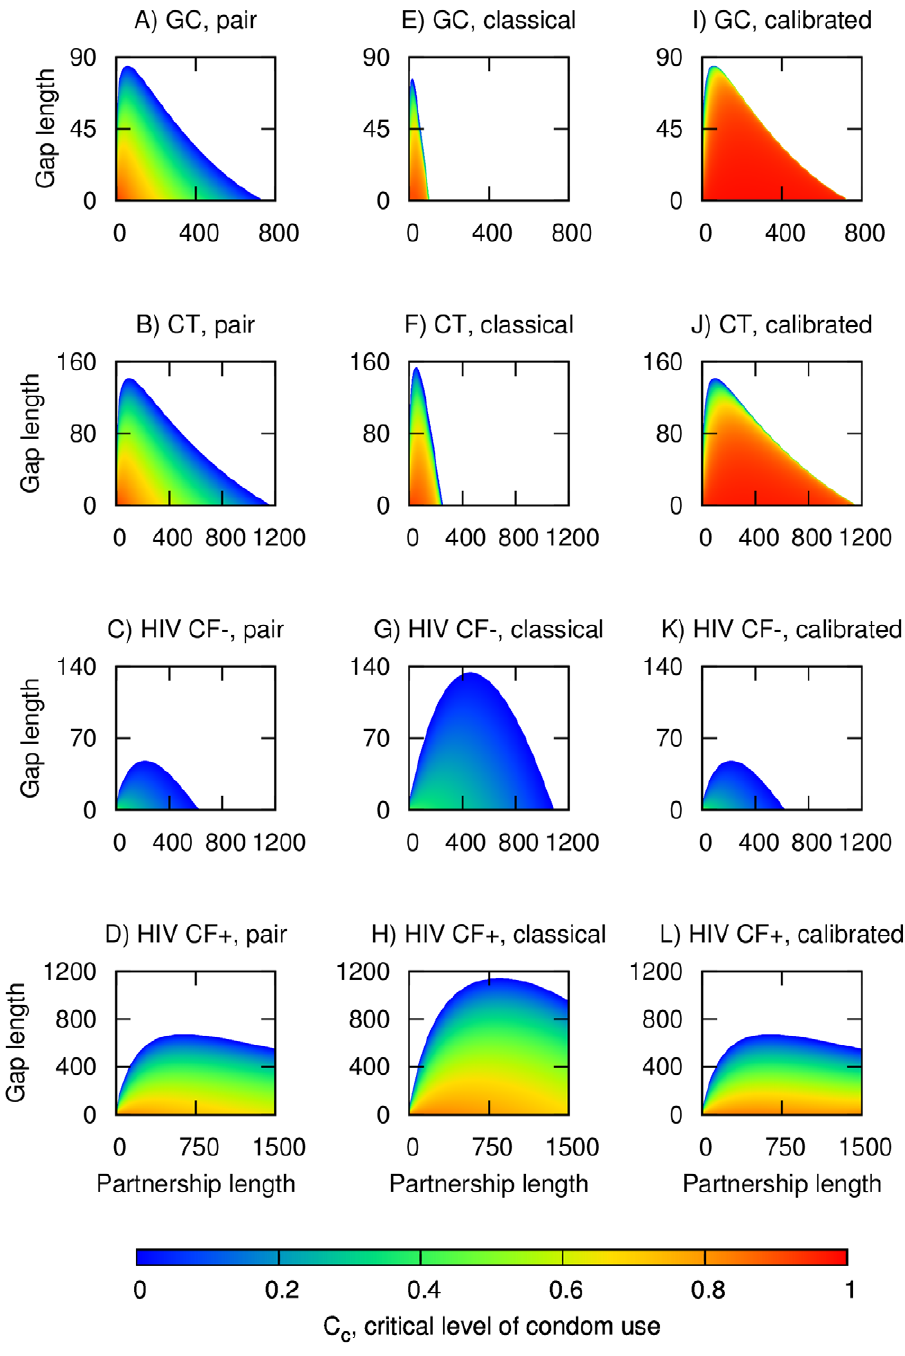
Figure 2. Critical level of condom use ( C c ) predicted to prevent self-sustaining GC/CT and HIV transmission for the pair (A to D), classical uncalibrated (E to H), and classical model following calibration of p to the pair model output (I to L). The horizontal axes give partnership length in days while the vertical axes give gap length in days. C c values are denoted by a gradient of colours as indicated; values of 0% demarcate the most extreme combination of partnership and gap lengths which supports self-sustaining transmission, while values above 100% (up to a theoretical maximum of 111% since condoms are assumed to be only 90% effective in preventing transmission) show partnership and gap combinations where consistent condom use is insufficient to prevent self-sustaining